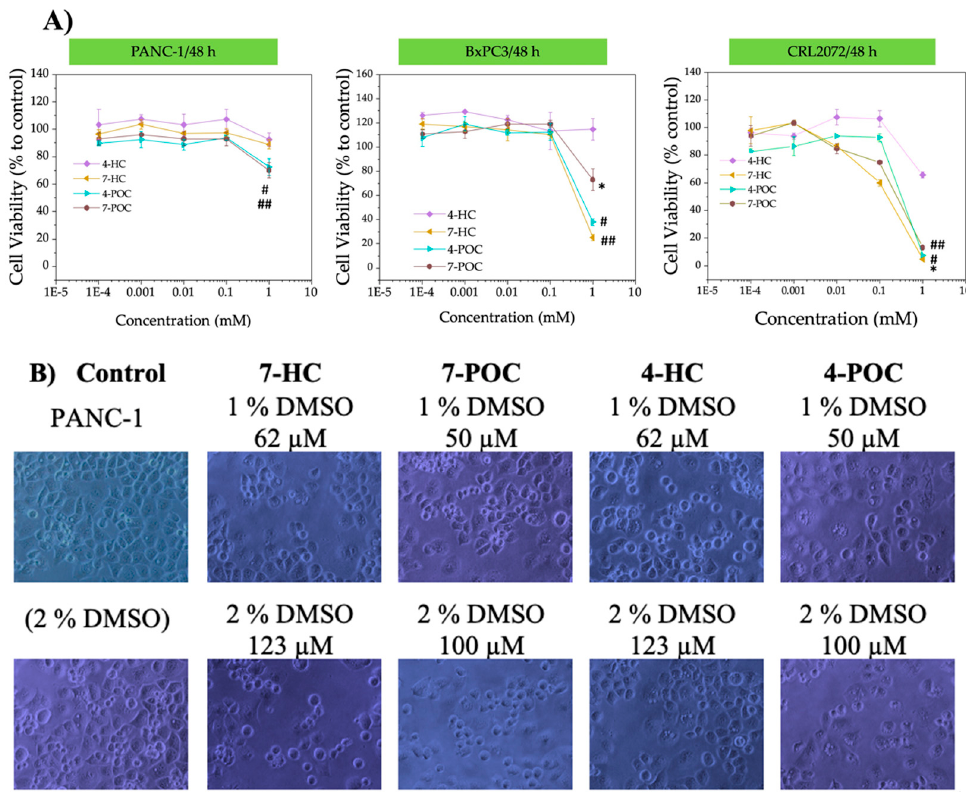
Figure 5. ( A ) Cell viability of PANC ‐ 1, BxPC3, and CRL ‐ 2072 cells treated with 4 ‐ HC , 7 ‐ HC , 4 ‐ POC , and 7 ‐ POC at different doses (from 0.0001 μ M to 1 μ M, in a solution of water with 1–2% DMSO) after 48 h of incubation (MTT assay). Values represent means of three replicates ± SD of one representative experiment. * p < 0.05, 7 ‐ HC group. # p < 0.05, 4 ‐ POC group. ## p < 0.05, 7 ‐ POC group. ( B ) Microscopic images (magnification 20×) of the PANC ‐ 1 cells after treatment.